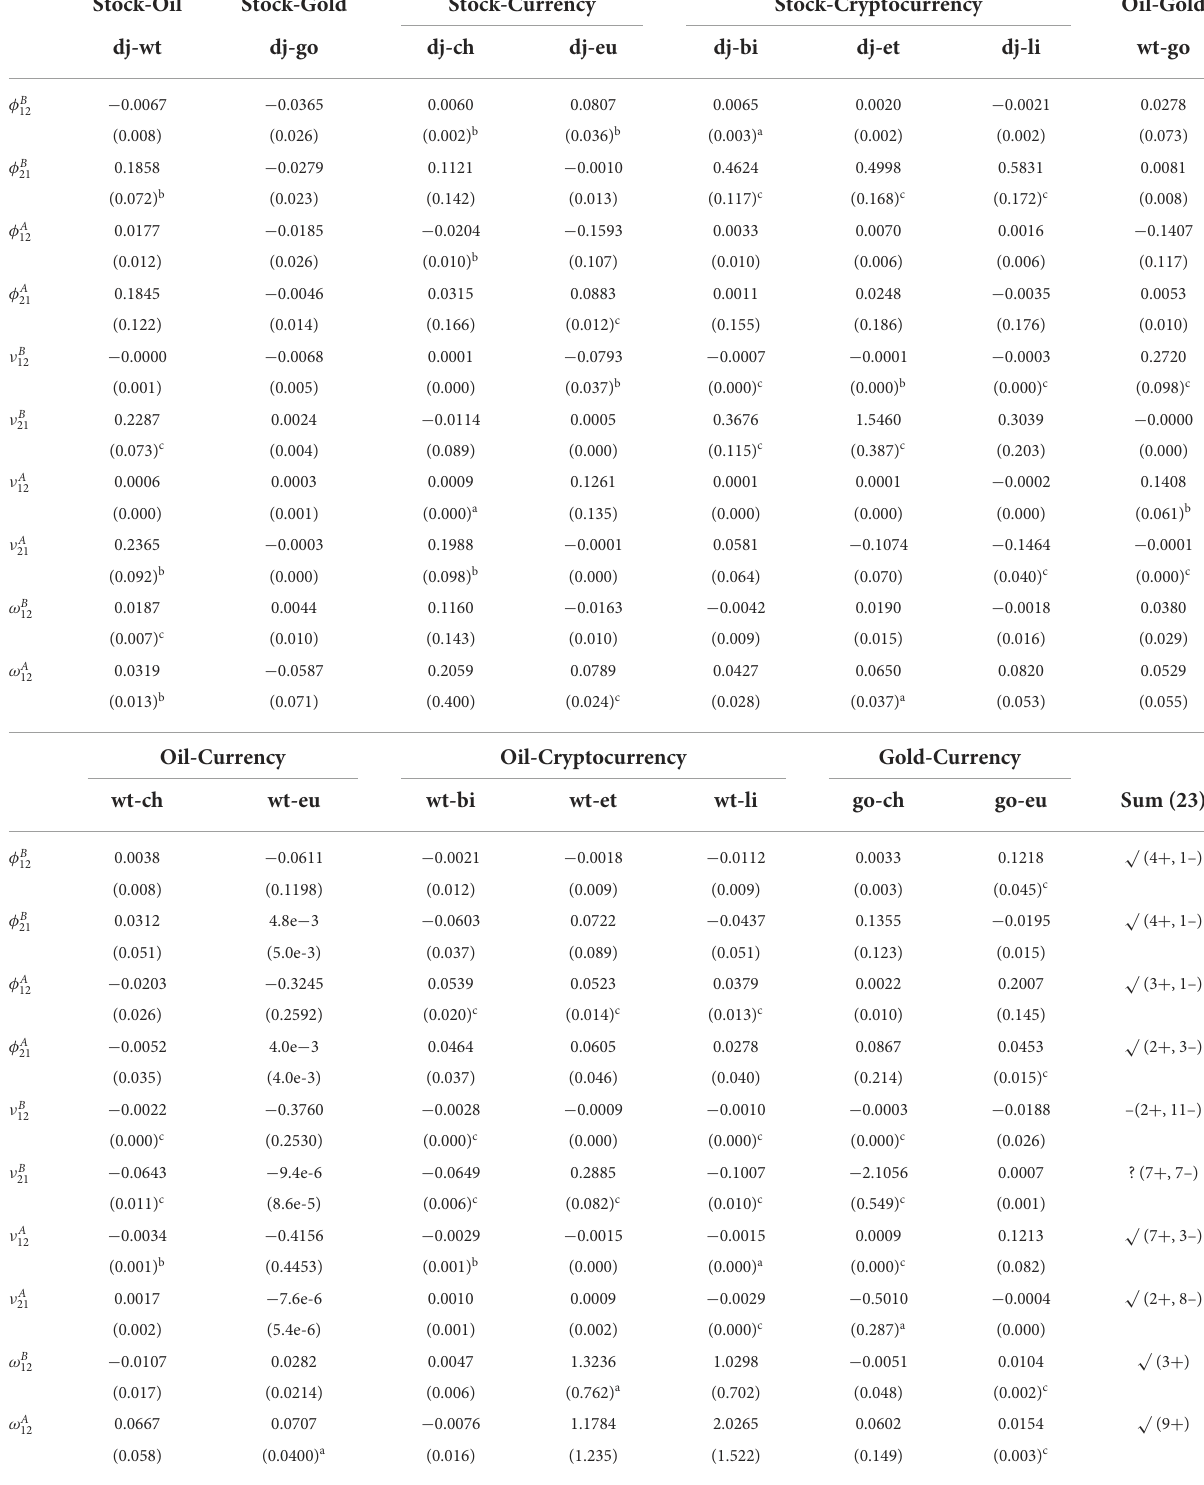
TABLE 3 The results of three types of interactions for all the 10 paired